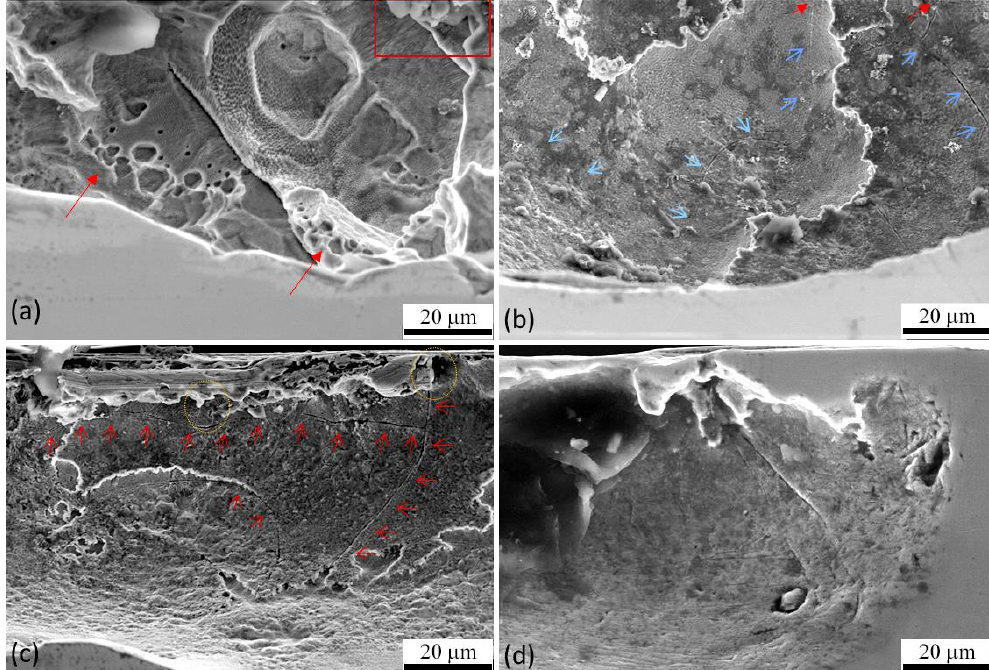
Figure 11. SEM Images of specimens with 310 MPa RS magnitude at different immersion times and magnifications ( a ) after 150 s showing the initiation of the crack from surface pits ( b ) after 400 s with the evidence of stress corrosion cracking (SCC) propagation along the melt pool boundaries and dominant surface pores and pits as precursors for SCC initiation ( c , d ) crack propagation in early stages of corrosion attack on the surface with higher magnification showing selective corro- sion and SCC attack along the columnar grains and melt pool boundaries.